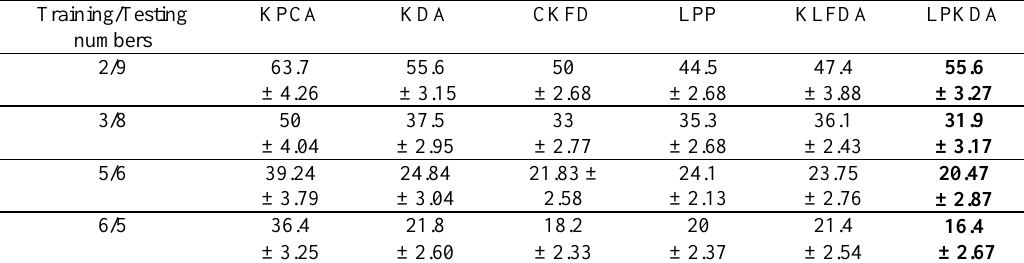
Table 3. The average error rates (%) across 10 tests and their standard deviations (std) on Yale database. Training/Testing